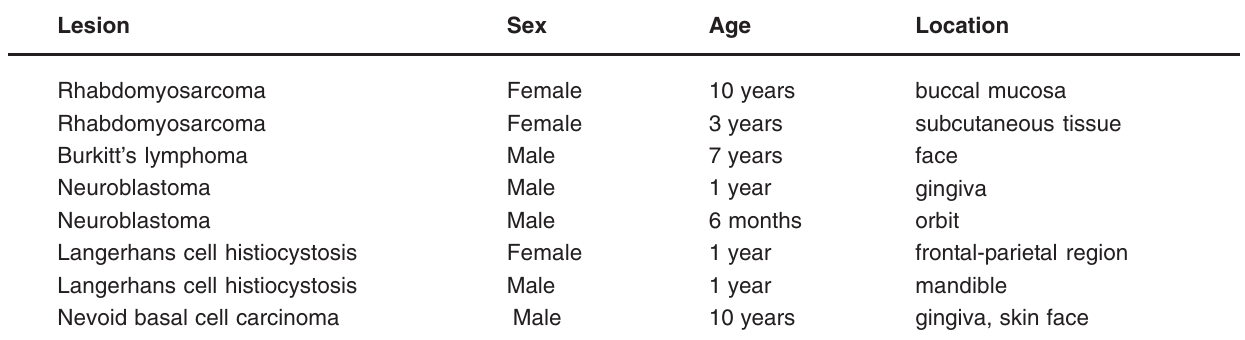
TABLE 2- Malignant